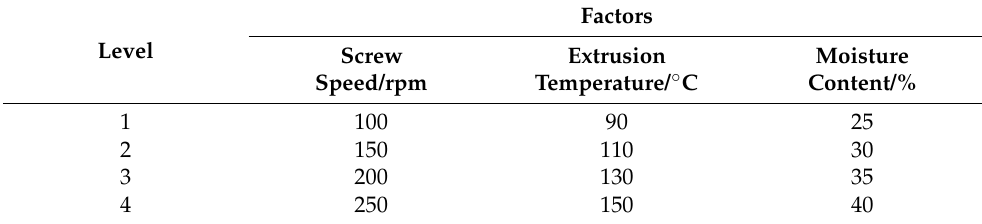
Figure 1. Twin-screw configuration and extrusion process. Table 1. The element and corresponding level of experiment.